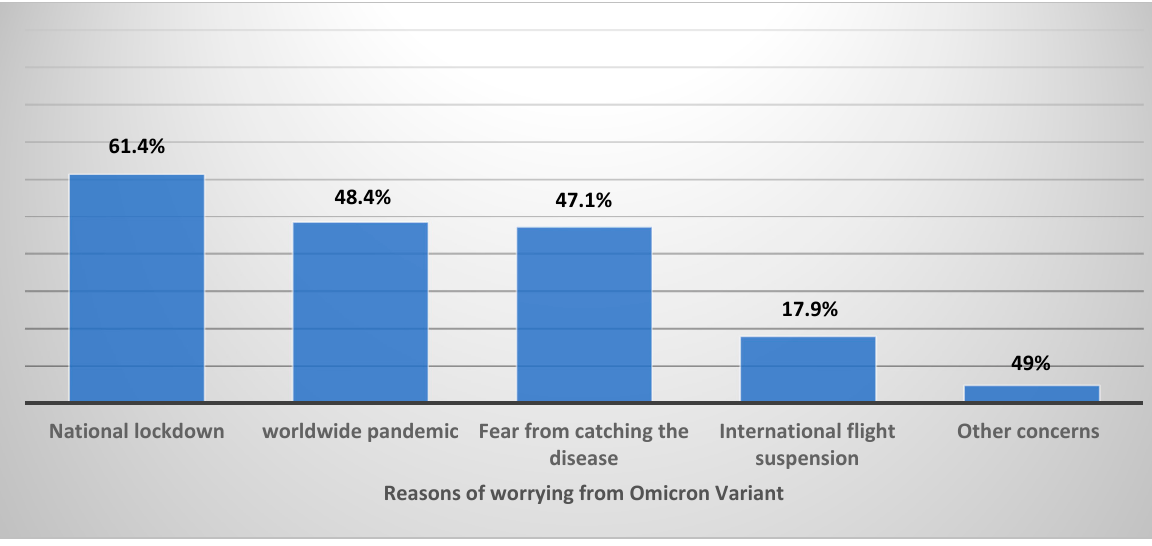
Figure 2. Parents’ reasons for worry in relation to the Omicron